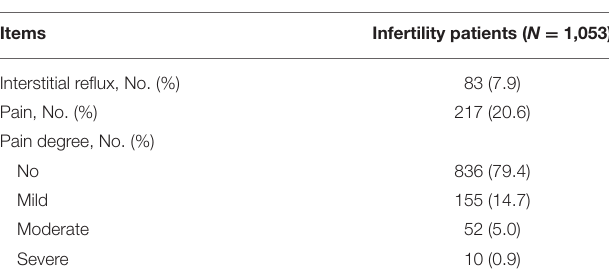
TABLE 6 | Adverse